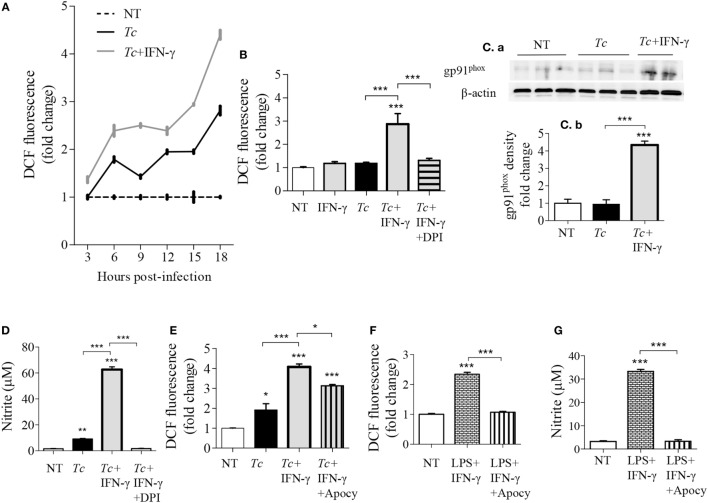
NOX2-dependency of reactive oxygen species (ROS)/nitric oxide (NO) generation in macrophages stimulated with Trypanosoma cruzi (Tc). RAW264.7 macrophages were stimulated with Tc for 18 h in presence or absence of IFN-γ and inhibitors of NADPH oxidase, diphenyliodinium (DPI), or apocynin (apocy). (A) Intracellular ROS levels were measured for 3–18 h post-infection (pi) by DCF fluorescence. (B,E) ROS levels with NOX2 inhibition by DPI (B) and apocynin (E). (C) Immunoblot analysis of gp91phox in macrophage cell lysates at 18 h pi [(C)a], normalized to β-actin loading control [(C)b]. (D) Nitrite release by infected macrophages at 18 h, with NOX2 inhibition by DPI, was measured by Griess assay. (F,G) Macrophages activated with lipopolysaccharide + IFN-γ in presence or absence of apocynin for 18 h. The ROS level (F) and NO release (G) were analyzed as above. All data are shown as mean ± SEM of ≥3 biological replicates (triplicate observations per replicate). Statistical significance (ANOVATukey) is presented by *p < 0.05, **p < 0.01, and ***p < 0.001 compared to no-treatment controls unless marked by a line over comparing groups.